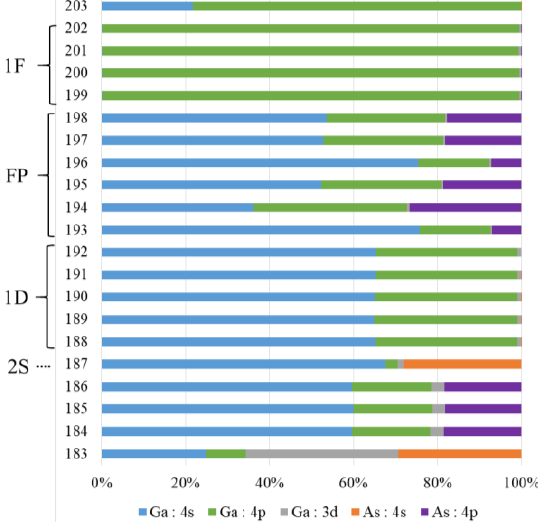
Figure 8. Ratio of atomic orbitals in order to create the superatomic-like orbitals of the As@Ga 12 cluster (interatomic As–Ga bond distance is 2.547 Å) by means of the Mulliken population analysis. The term “FP” from #193 to #198 denotes the hybridized F 3 P 3 superatomic-like orbitals.